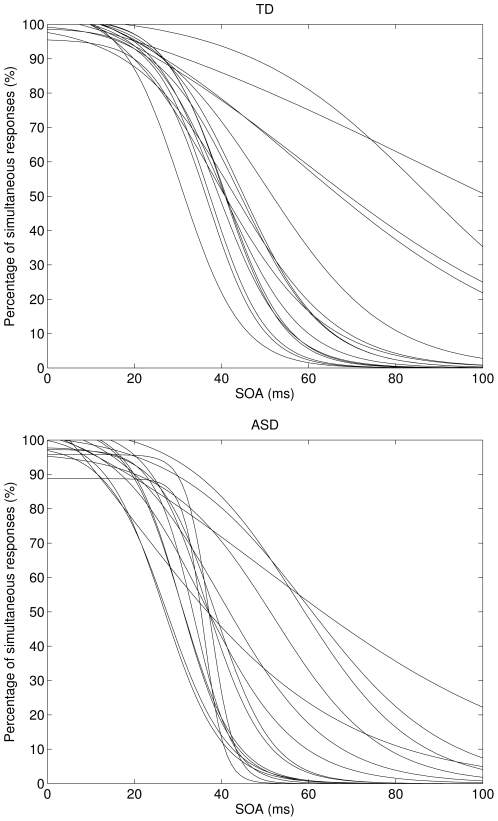
Individual curve fits.Sigmoid curves fit to the data of individuals from the TD group (top panel) and individuals with ASD (bottom panel) over stimulus onset asynchrony (SOA).